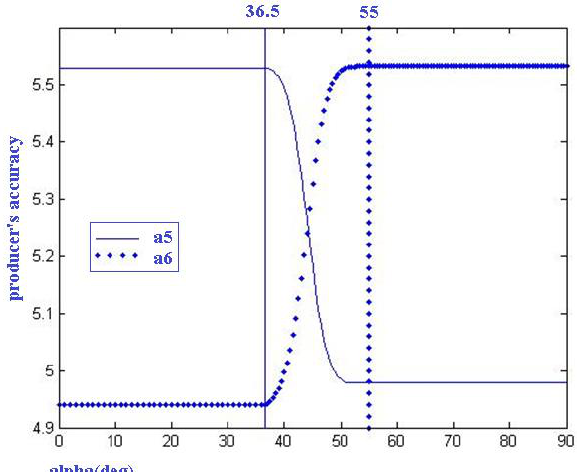
Fig.7. mean producer’s accuracy versus different values of the a5 and a6 boundaries.